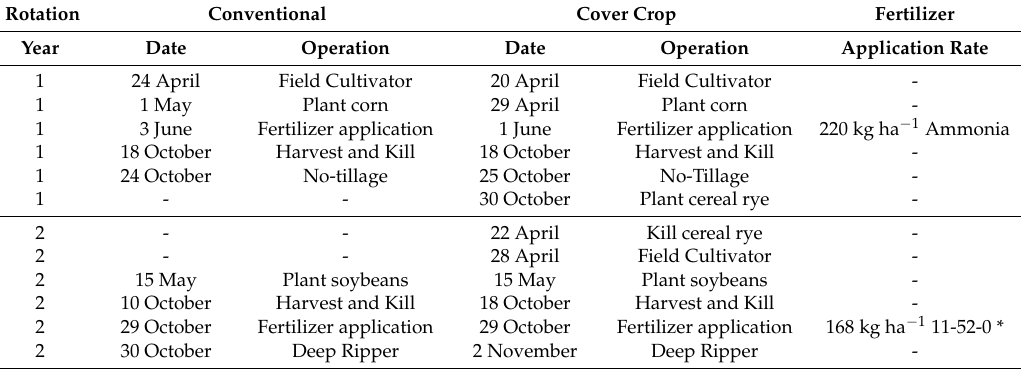
Table 1. Two-year corn and soybean conventional and cover crop rotations in the Eagle Creek watershed, Ohio Soil and Water Assessment Tool (SWAT)